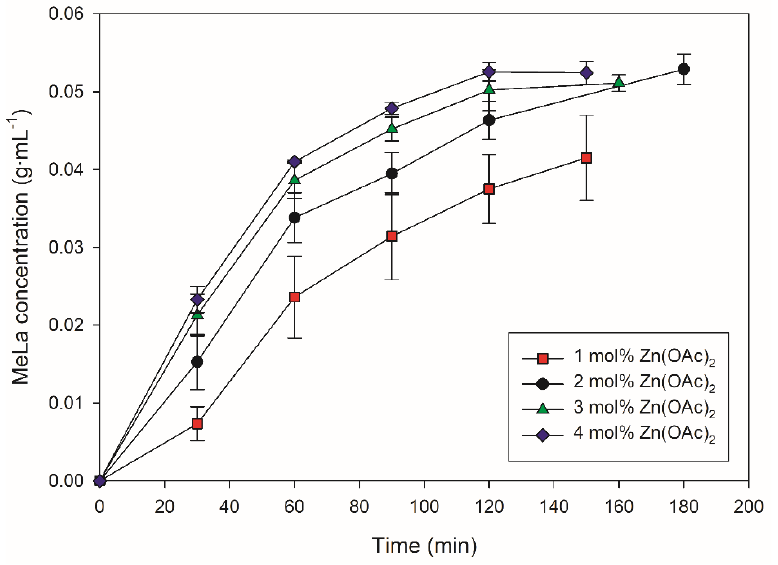
Figure 1. Methanolysis of 2 g of PLA at 130 ◦ C, 300 rpm and 9 equivalents of MeOH. Effect of mol% Figure 1 . Methanolysis of 2 g of PLA at 130 °C, 300 rpm and 9 equivalents of MeOH. Effect of mol% of Zn(OAc) 2 (Relative to mol of PLA) on the MeLa concentration (g ∙ mL −1 ) vs. Time (min). of Zn(OAc) 2 (Relative to mol of PLA) on the MeLa concentration (g · mL − 1 ) vs. Time